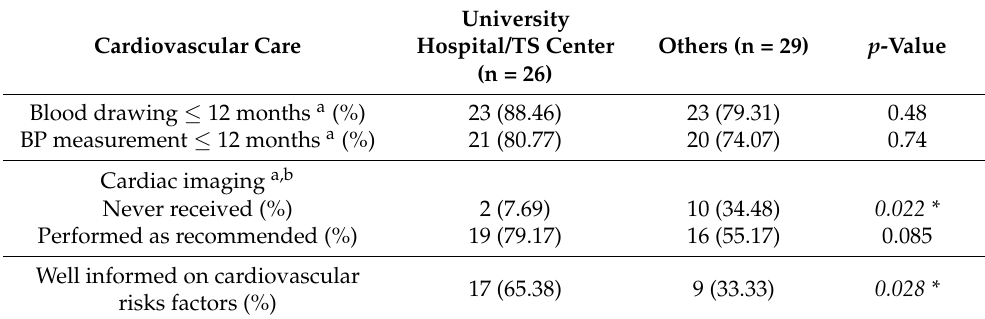
Table 4. Cardiovascular care of TS women without arterial hypertension and/or congenital heart disease in Germany.